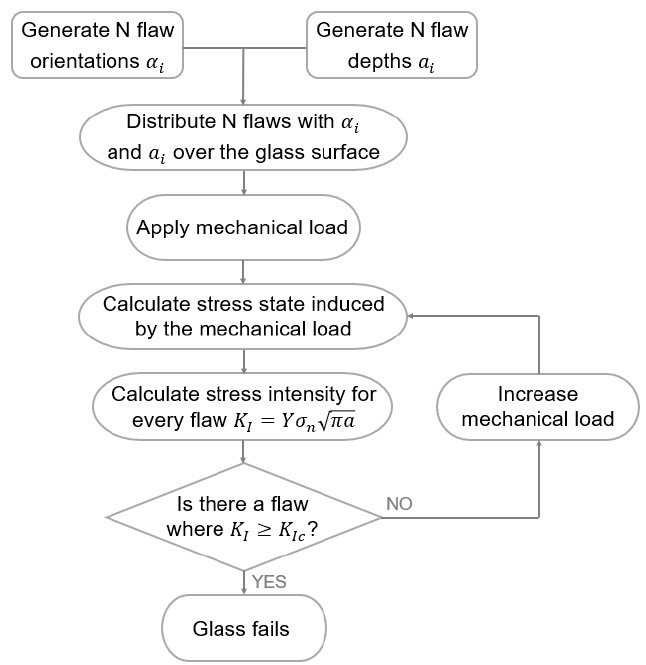
Figure 1. Flowchart for the evaluation of the glass strength using the strength prediction model.